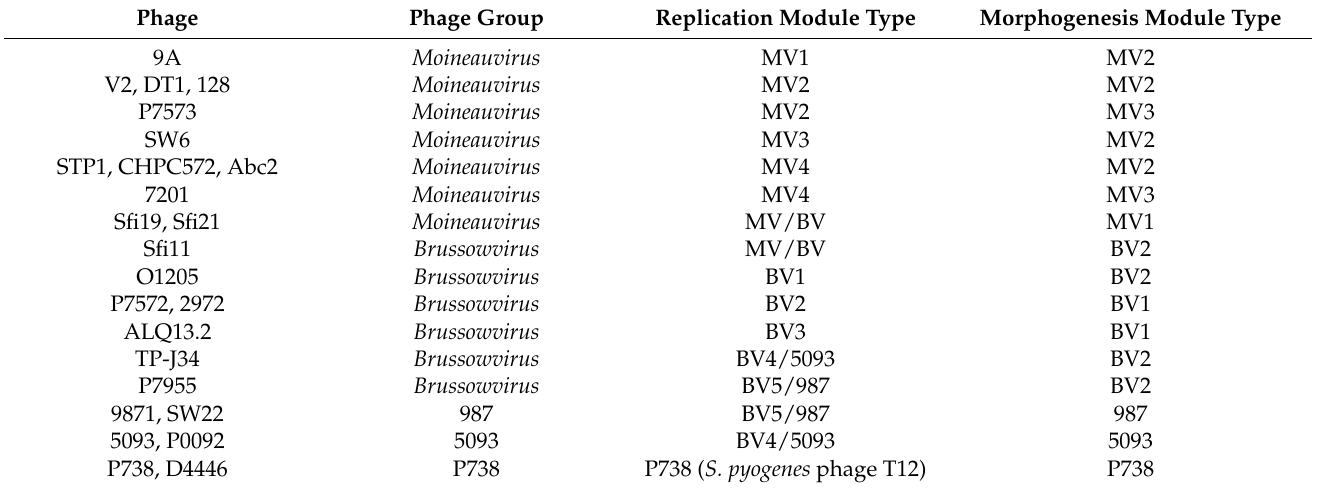
Figure 4. Proteomic tree highlighting distinct morphogenesis modules of the analyzed phages. Pink and purple clades and text boxes highlight those specific to Moineauvirus members (MV1, MV2 and MV3). Those colored light and dark green (BV1 and BV2) highlight Brussowvirus -specific morphogenesis modules; in blue is the single 5093-like module; orange relates to the P738-specific module and red indicates the 987-specific module. § denotes Moineauviruses; ‡ denotes Brussowviruses; the 5093 phages are represented by 5093 and P0092; the 987 group are represented by 9871 and SW22 and the P738 group are represented by P738 and D4446. Table 1. Summary of replication and morphogenesis module types based on structural and replication module phylogenetic